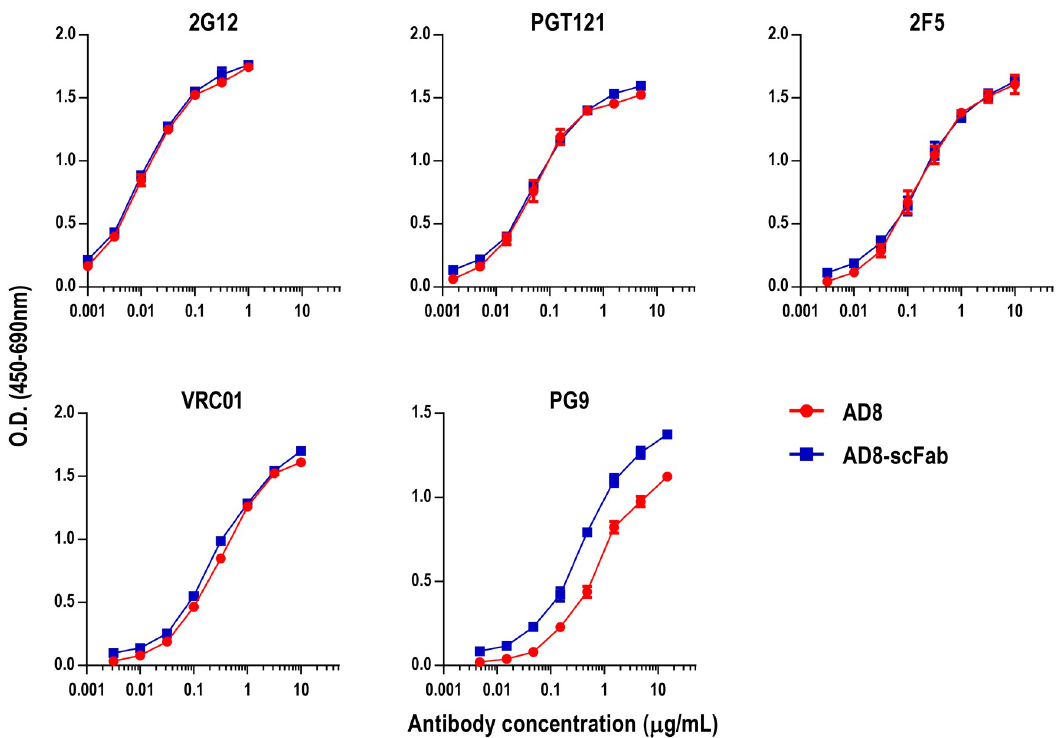
Fig 3. Binding of Clec9A-targeting constructs to bNAbs. Direct ELISAs were performed to assess the binding of Env constructs to bNAbs. ELISA plates were coated with 100ng/well AD8 gp140 (coating levels of AD8-scFab normalized based on molarity), then bNAbs were diluted in a half log series at the concentrations indicated. Graphs show the mean ± SEM of three independent experiments.